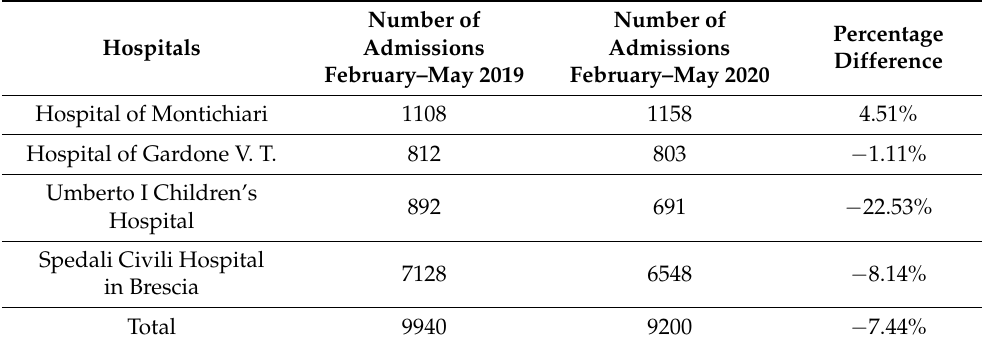
Table 9. Admissions to the ER.